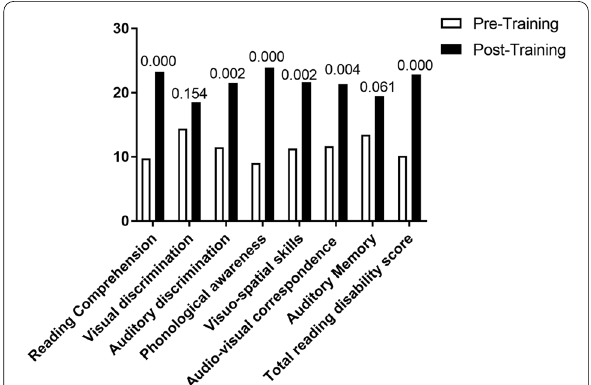
Fig. 1 Scores of CADB of 2nd-Grade Public School Students with Dyslexia (pre- vs post-training). There was a significant increase in post-training mean scores of the total ( P -value 0.000) as well as sub-items of the tested cognitive skill abilities of students with dyslexia ( N =